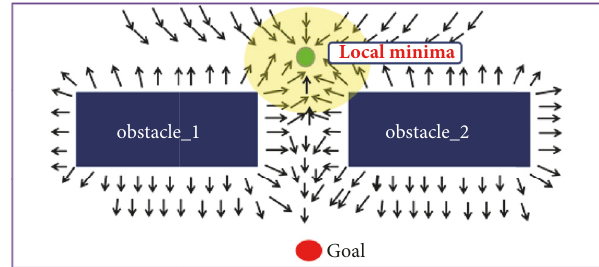
Figure 3: Local minima problem of conventional PFM.